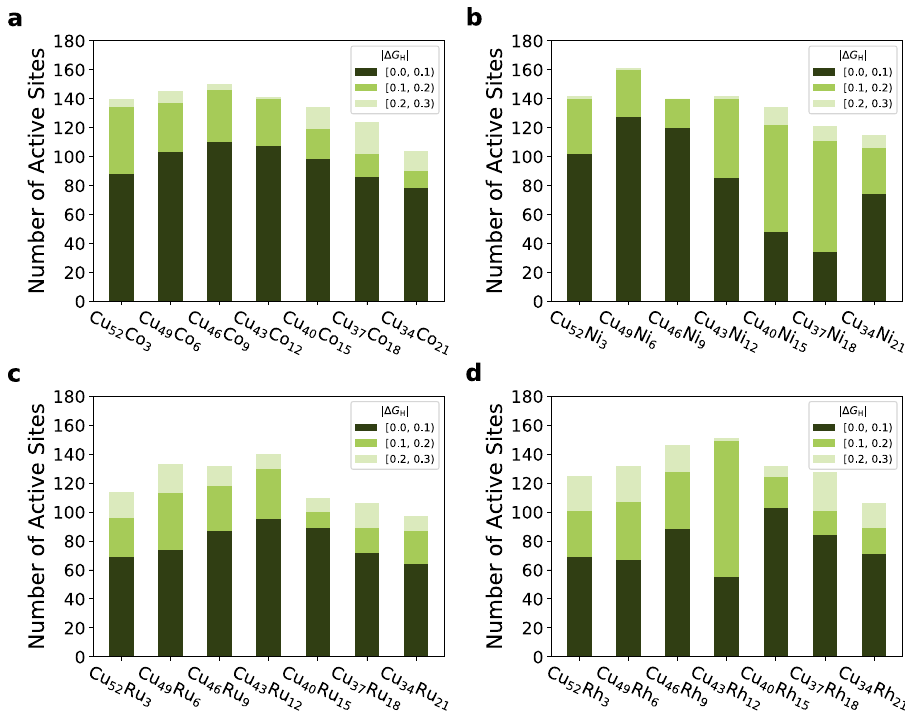
Fig. 5 HER activities of alloy catalysts. Total number of active sites counted in different ranges of | Δ G H | values as a function of various compositions for ( a ) Cu 55- n Co n , ( b ) Cu 55- n Ni n , ( c ) Cu 55- n Ru n , and ( d ) Cu 55- n Rh n alloy clusters. The dark green, green, and light green colors indicate the total number of active sites with the | Δ G H | values in the range of [0.0, 0.1), [0.1, 0.2), [0.2, 0.3),